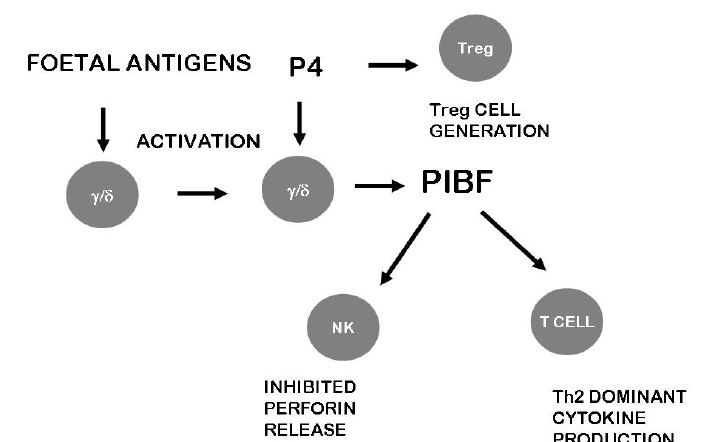
Figure 1. The effects of PIBF on the immune system. Following activation by foetal antigens, maternal lymphocytes express PRs, and in the presence of progesterone, produce PIBF. The small PIBF isoforms bind to the PIBF receptor and activate signaling pathways that lead to increased production of Th2 cytokines. By inhibiting degranulation of NK cells, PIBF contributes to the low NK activity. These together with the positive effect of progesterone on regular T (Treg) cell generation are crucial for moderating anti foetal immune